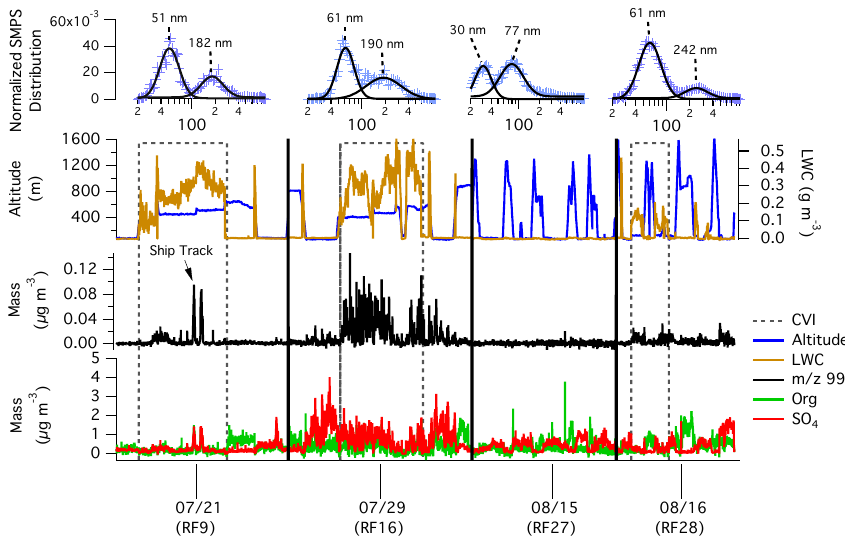
Fig. 11. Time series of organic, sulfate, organic m/z 99, LWC and altitude for research flights RF 9 (moderately clean, clouds), RF 16 (perturbed, clouds), and two additional flights that were performed outside the sampling region defined in Fig. 1, RF 27 (moderately clean, no clouds) and RF 28 (moderately clean, clouds). The top row of normalized aerosol number distributions (d N /dlog D p /(integrated loading)) show the distribution of marine aerosol below cloud for each flight. The dotted boxes show periods when samples were collected through the CVI inlet.